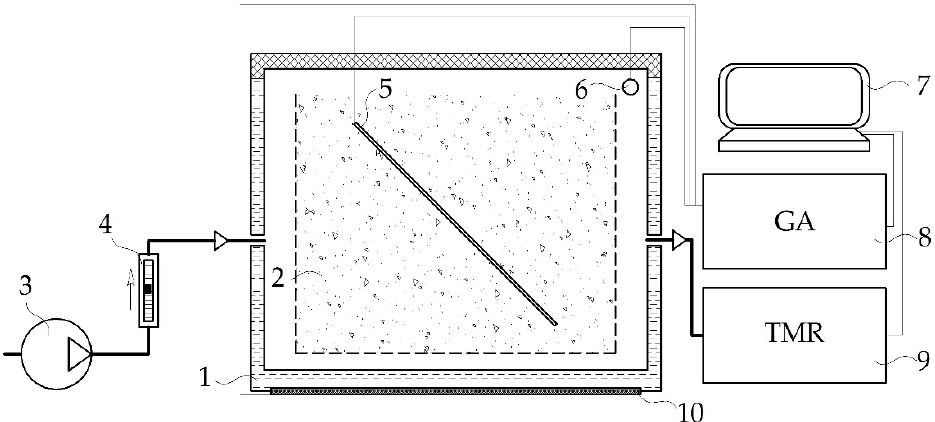
Figure 1. Schematic image of a laboratory bioreactor for the aerobic solid-state biodegradation of organic waste: composting chamber (1); compost mixture (2); compressor (3); air flow regulator (rotameter) (4); temperature sensors (5 and 6); computer (7); gas analyzer (GA) (8); temperature meter-regulator (TMR) (9); and heating element (10).